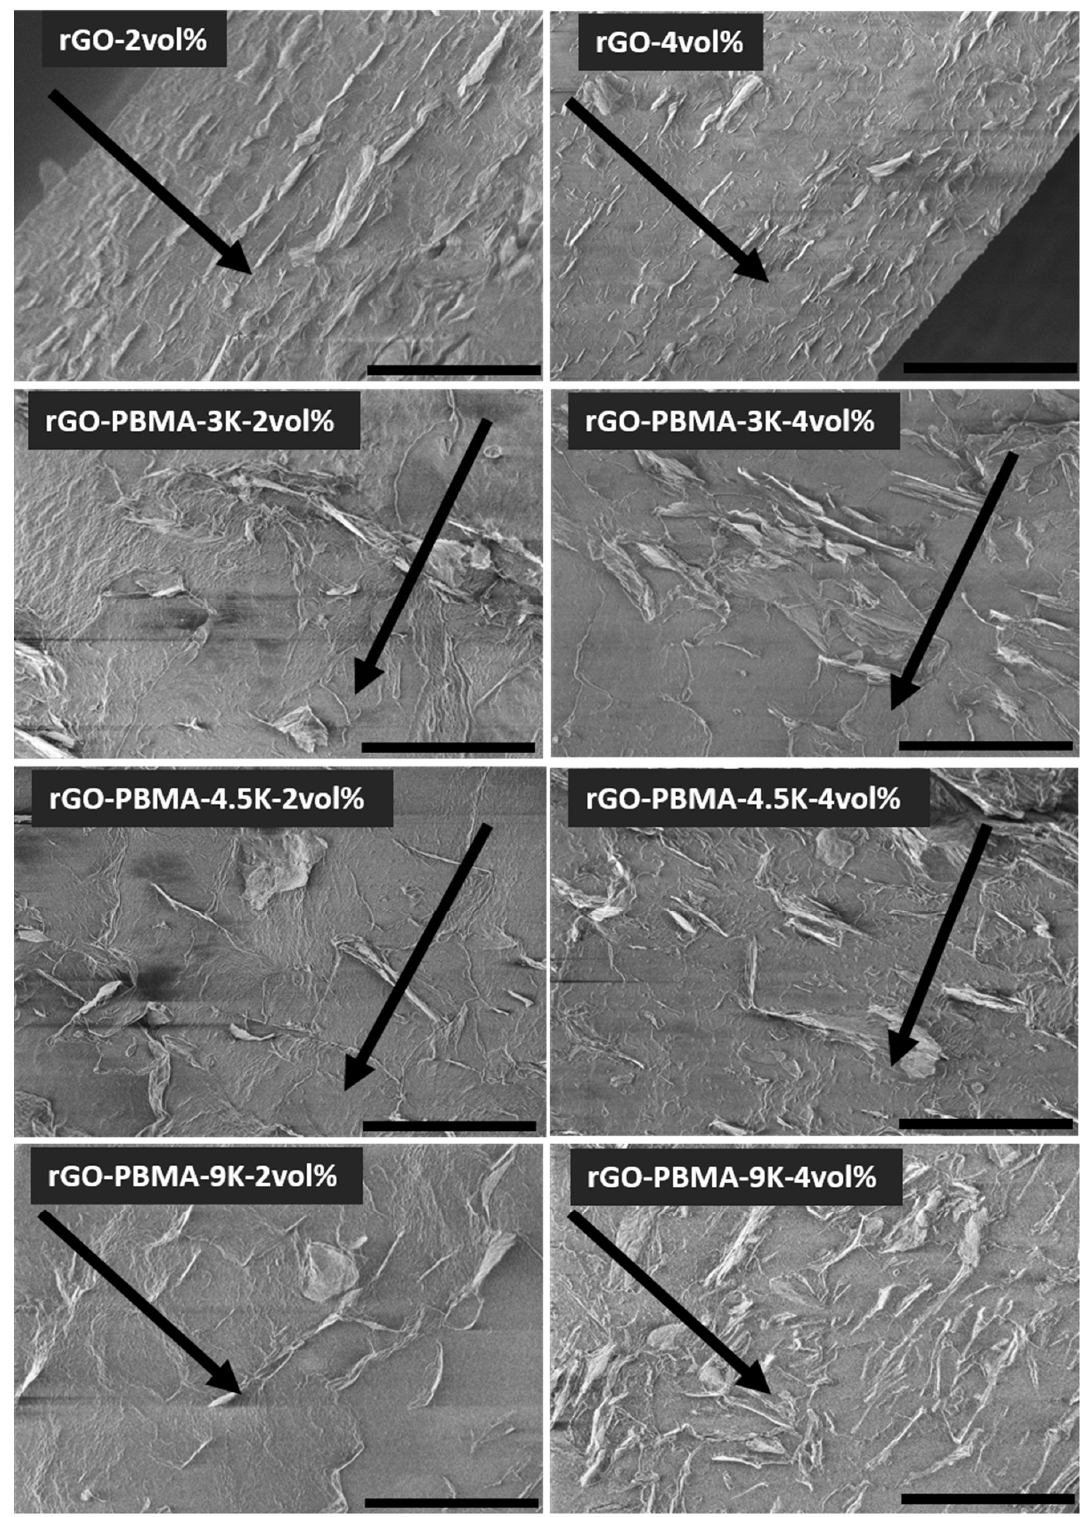
Figure 3. SEM micrographs of cross-sections of the nanocomposites, the arrows indicate the film direction (i.e., perpendicular to the pressing direction). The unmodified rGO sheets are clearly aligned in the film direction (top row). The polymer-grafted rGO gradually develop a more random direction with increasing length of the polymer brushes. All scale bars are 20 µm.